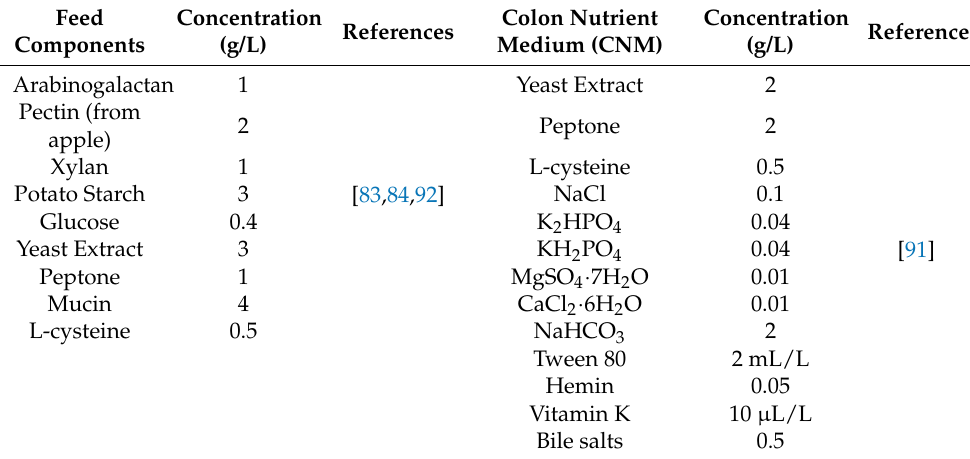
Table 3. Nutritional media composition of the administered feed to the SIMGI model, including Colon Nutrient Medium used for colon-only